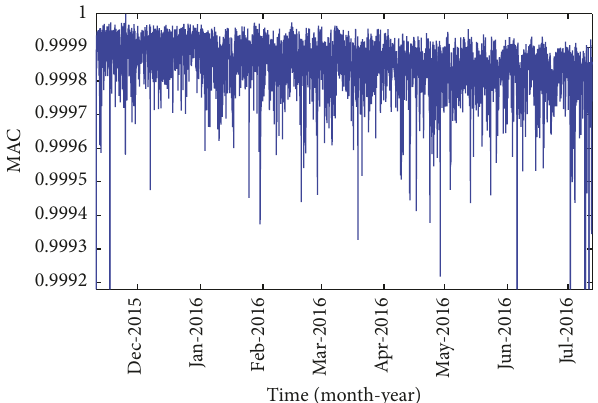
Figure 10: Time trend of the MAC of the first mode.